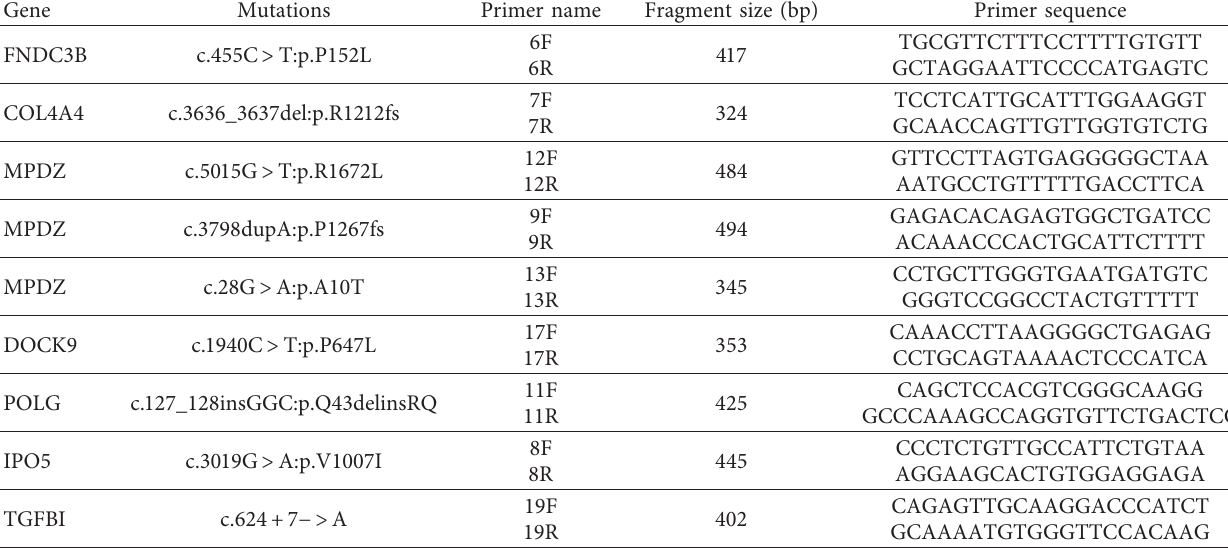
Table 2: Sequences of primers used in this